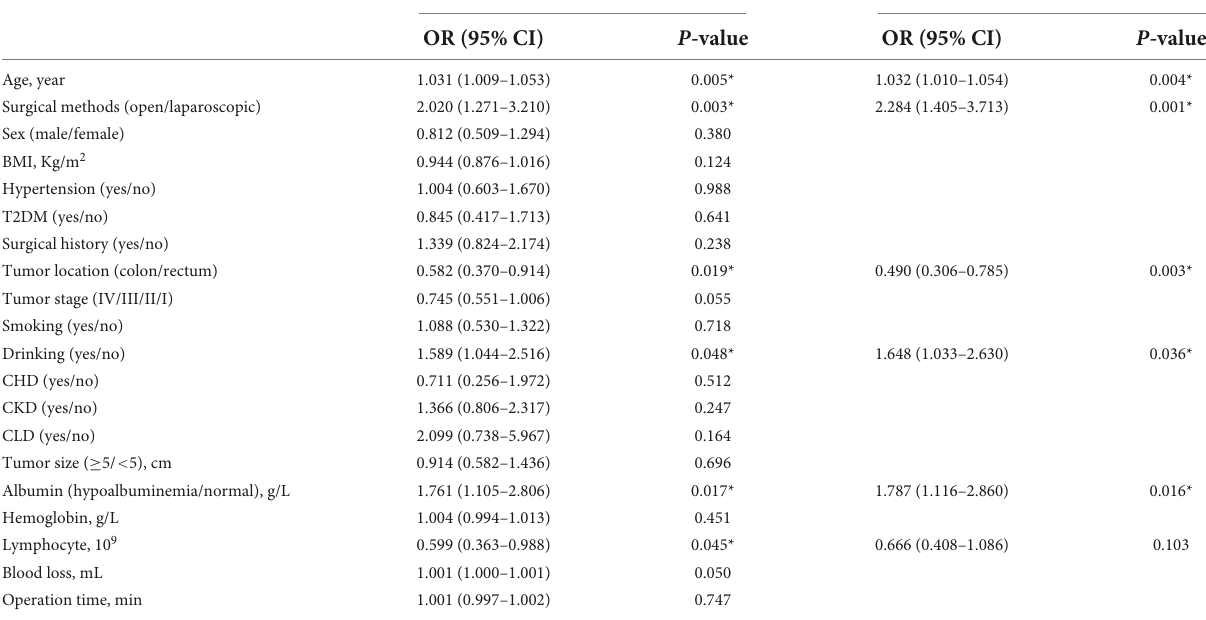
TABLE 4 Univariate and multivariate logistic regression analysis of the major complications.